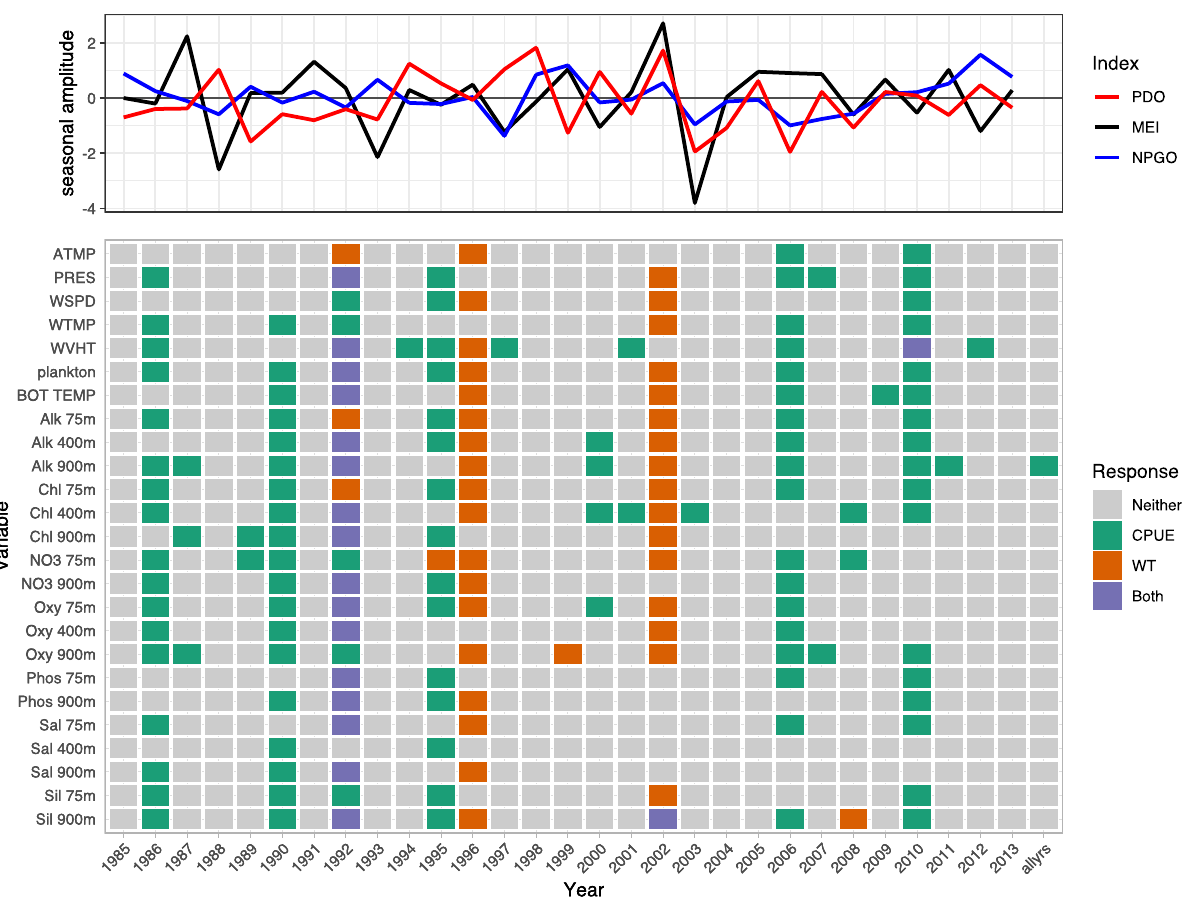
Figure 1. Variable selection analyzed for each available year and all years together for the SIVCMs with Pacific cod CPUE or WT as the response. X-axis represents years for which selection was performed, and all available years of data used in selection labeled as “allyrs”. Y-axis contains all variables in SIVCM from which selection was performed. Colors indicate selection of variable(s) important to CPUE, WT, neither response, or both responses, along with years missing either CPUE or WT response values. Line plot at top shows lagged seasonal amplitude values for the Pacific Decadal Oscillation (PDO), multivariate El Niño/Southern Oscillation (MEI), and North Pacific Gyre Oscillation (NPGO) for corresponding